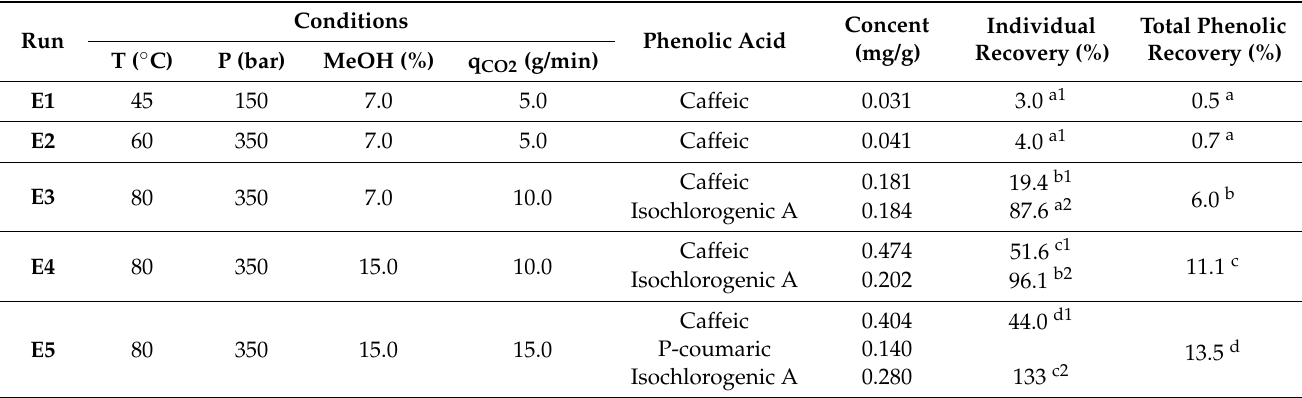
Table 3. Phenolic acid supercritical fluid extraction from potato peels in screening runs. The extraction time was fixed at 60 min in all